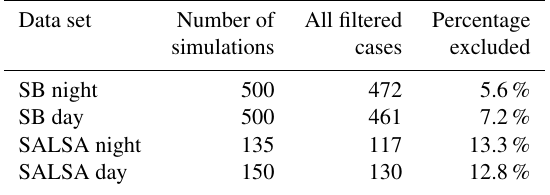
Table 2. Filtering of the LES